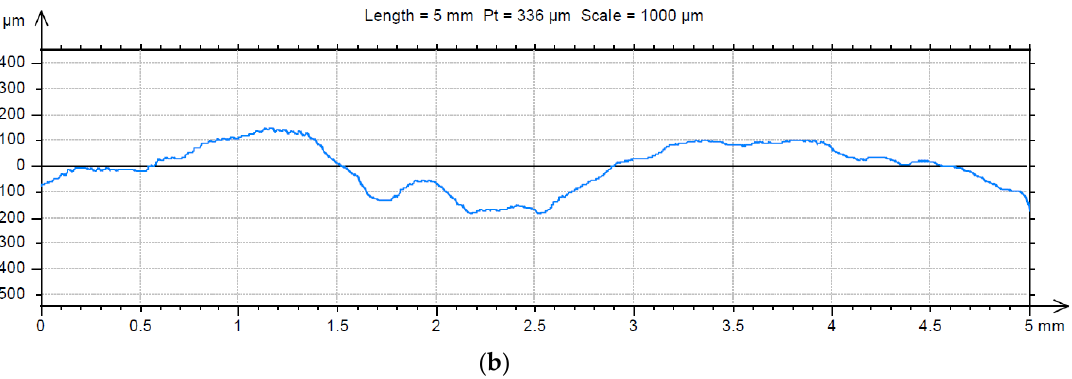
Figure 5. Representative profile lines for the reference material (galvanized steel) ( a ) and biofilm coated material ( b ).